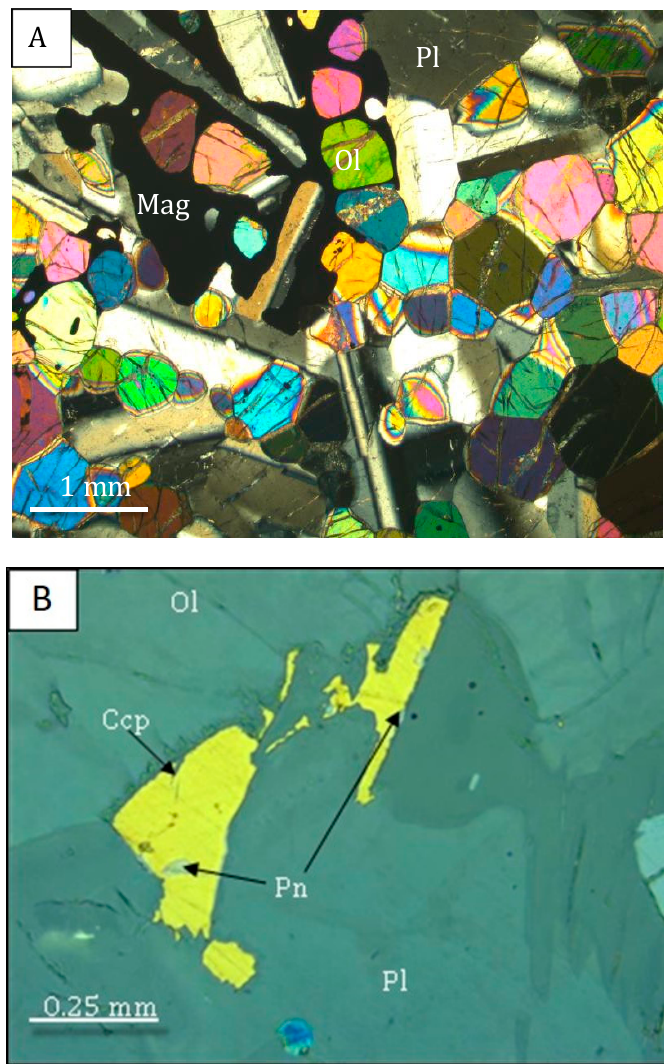
Figure 3. Troctolite showing: ( A ) Intergranular texture between plagioclase and olivine (Ol). Interstitial titaniferous magnetite (Mag) is seen surrounding grains of plagioclase (Pl) and olivine (transmitted light); ( B ) Fine intergrowths of chalcopyrite (Ccp) and pentlandite (Pn) in the interstices of olivine and plagioclase (reflected light). The blue hexagonal grain at the bottom is digenite.